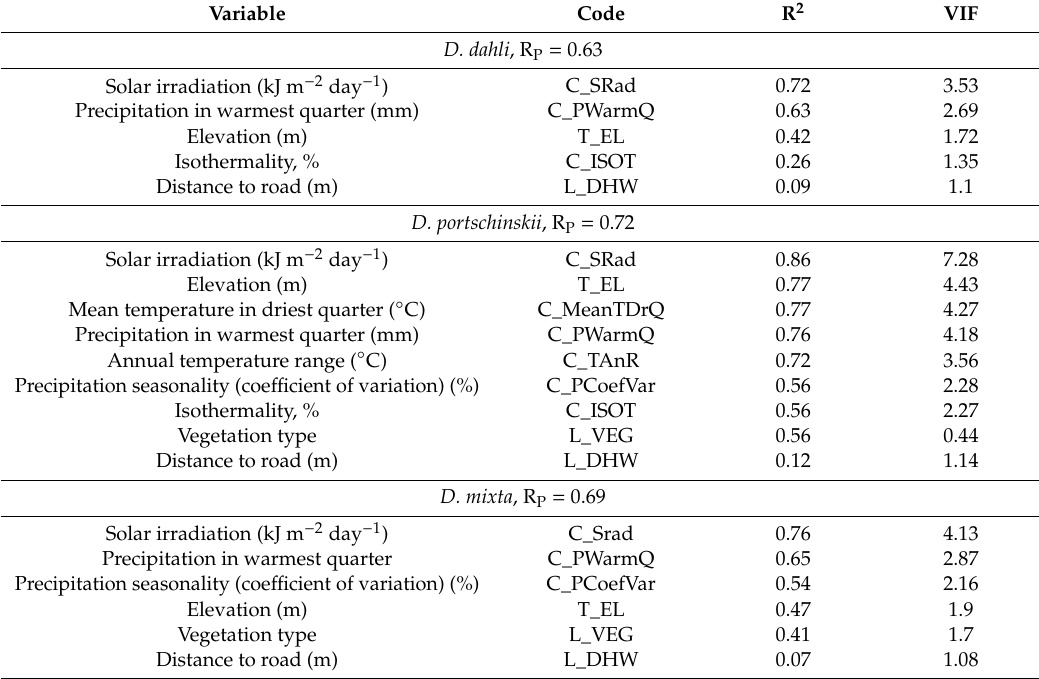
Table 1. The list of predictor variables selected for building SDM of D. dahli , D. portschinskii and D. mixta , where R P is the largest value of the Pearson’s correlation coe ffi cient; R 2 is the coe ffi cient of determination of a linear regression of each predictor variable on all other predictor variables, VIF is Variance Inflation